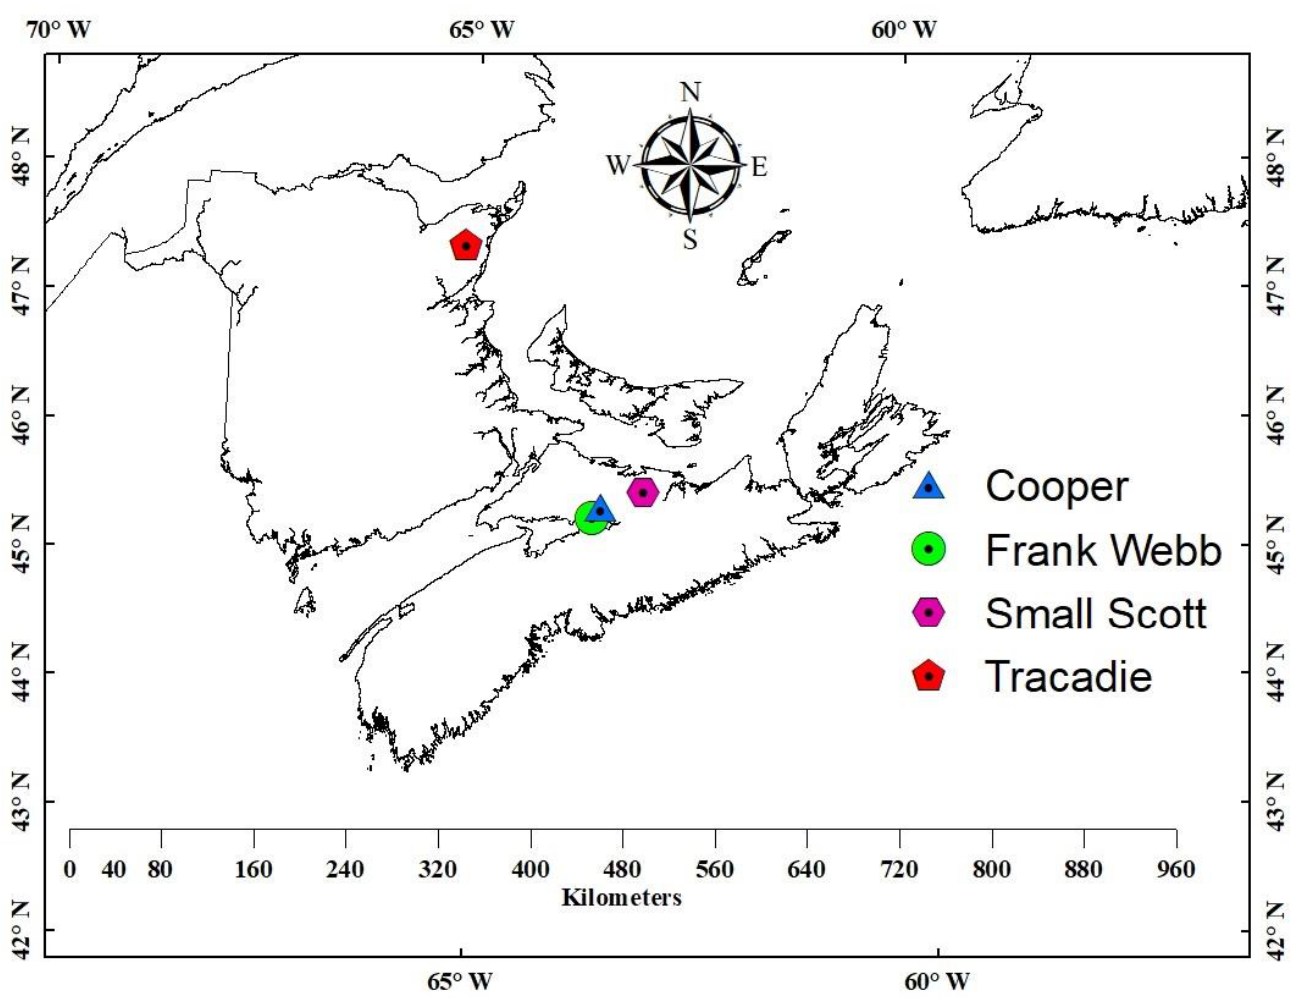
Figure 1. Selected blueberry fields in two Atlantic provinces (New Brunswick and Nova Scotia).